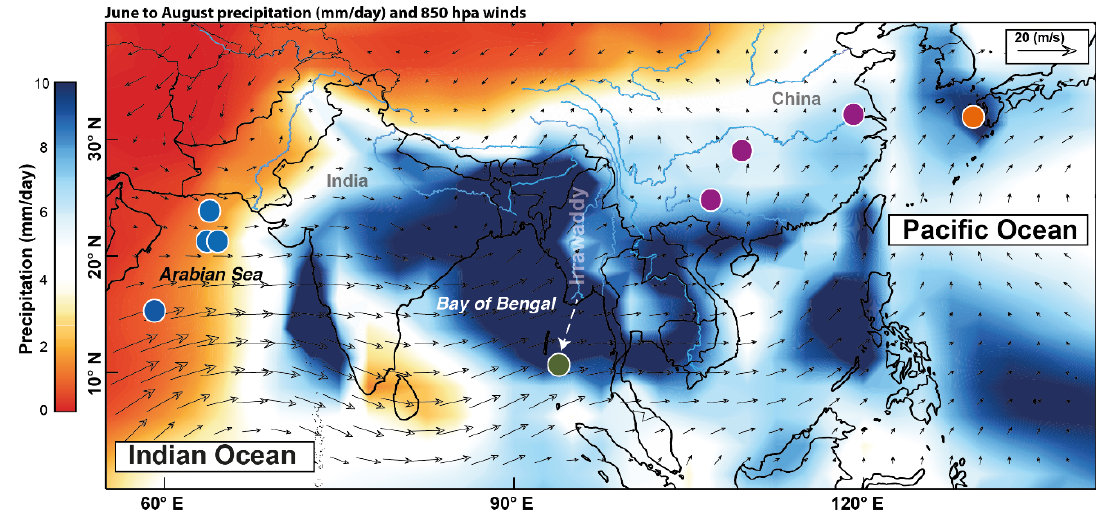
Figure 1. June–August mean precipitation (mm / day) and 850-hPa winds in the Asian monsoon domain for the period 1979–2015 (GPCC precipitation data provided by the NOAA / OAR / ESRL PSD and can be accessed at https: // www.esrl.noaa.gov / psd / ). Orange and green filled circle shows the location of marine core sites in the East China Sea [14] and the Andaman Sea [15]. Purple filled circles show the locations of the three main Chinese caves (Dongge cave–Southern China; Sanbao cave–Central China; and Hulu cave–Eastern China) [4]. Also shown are some of the Arabian Sea marine core sites (all in blue) from [17] and [18].